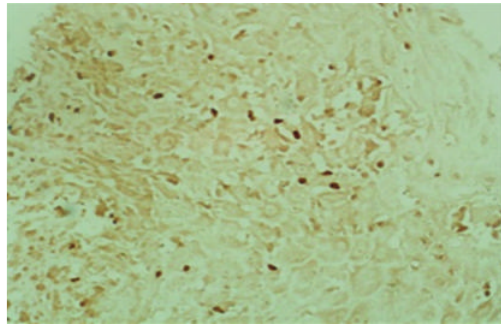
Figure 6: Of patient no. 1. Lesion section shows T inflammatory infiltrate. Normal skin was negative for T